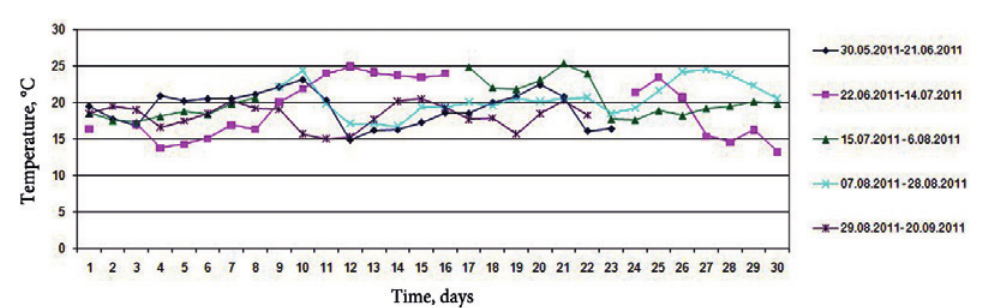
Fig. 3. Variation of temperature along the duration of the phenological phases